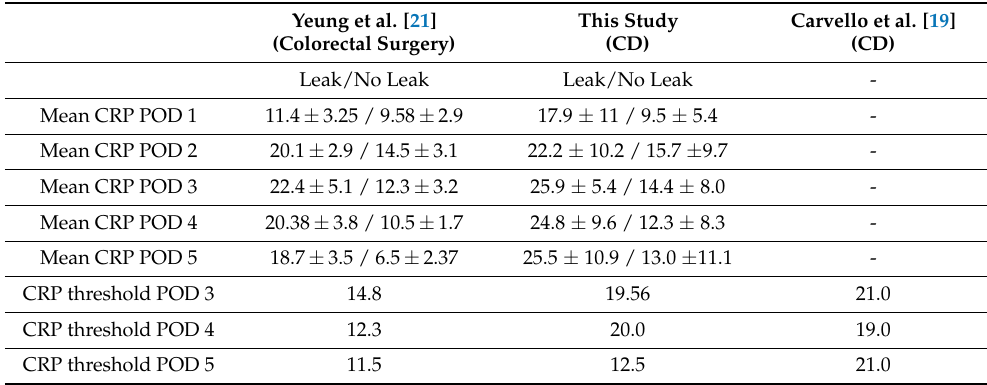
Table 5. Mean CRP levels and CRP threshold